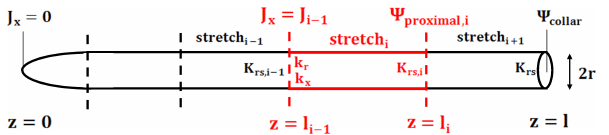
Figure 2. Single root made of five stretches (the dashed vertical lines are stretch boundaries). For root stretch i , boundary condition at z = l i − 1 (distal end) is the water flow J i − 1 and at z = l i (proxi- mal end) the xylem water potential (cid:57) proximal ,i . For details, see